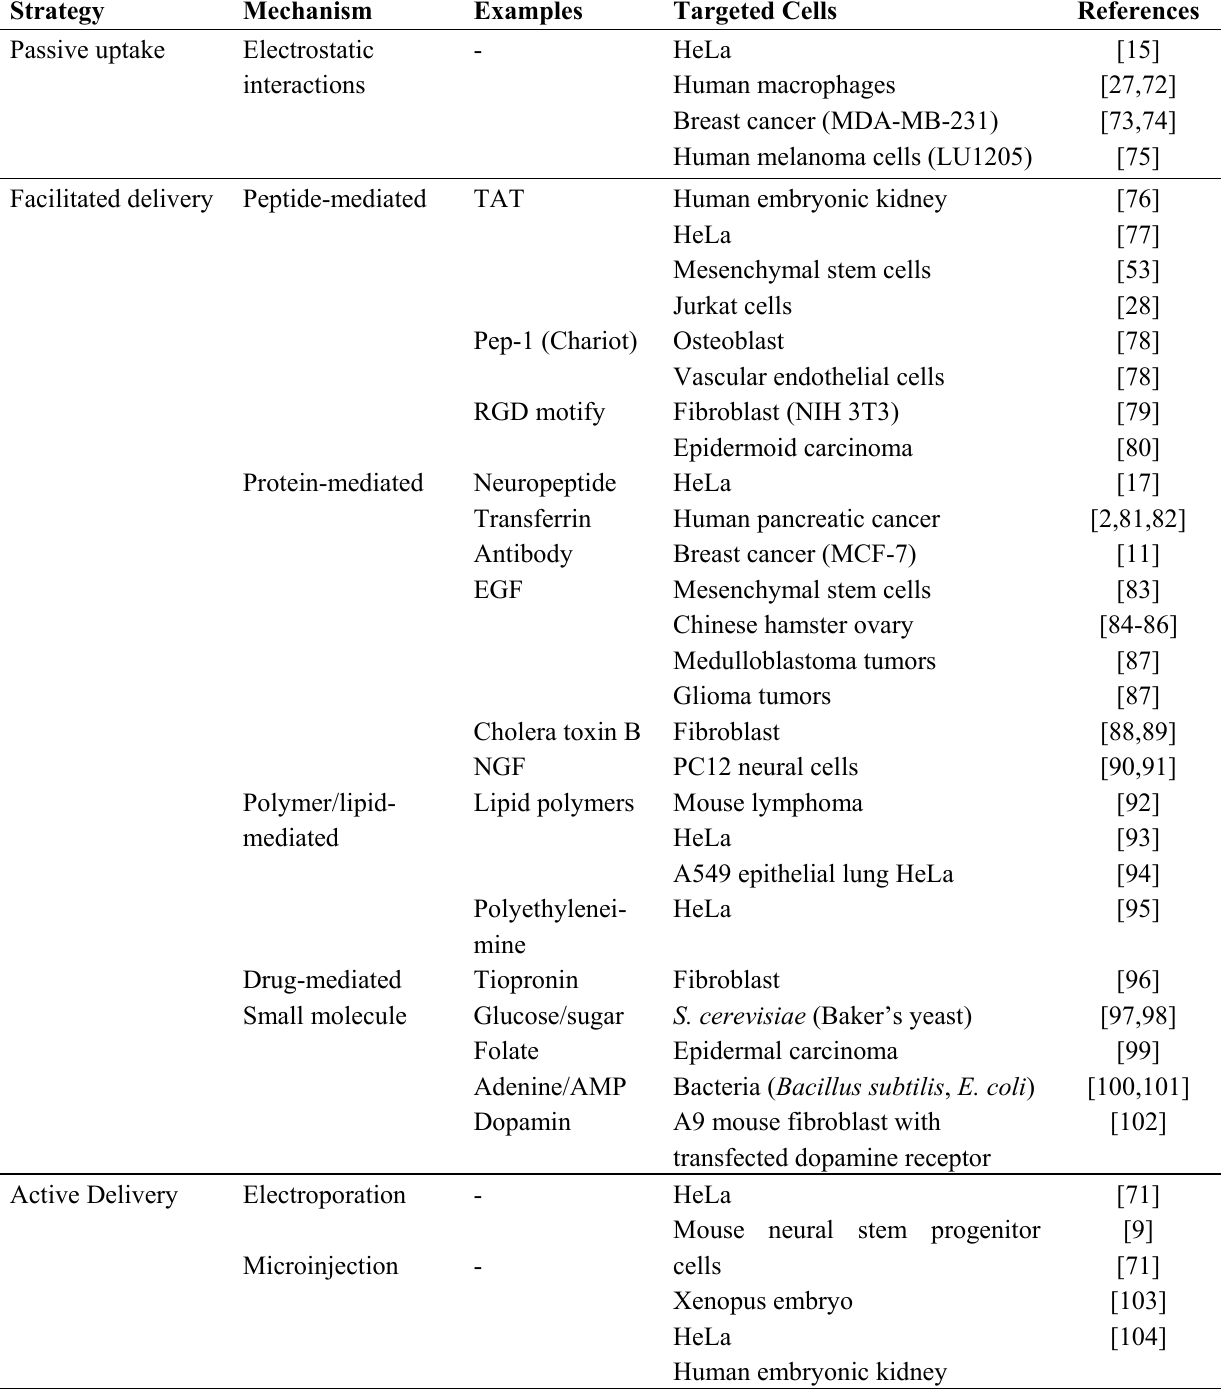
Table 1. Selected strategies for the intracellular delivery of